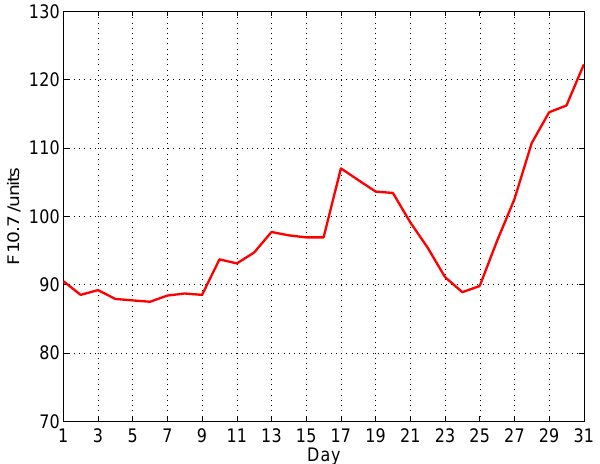
Fig. 5. The F10.7 (solar radio flux) index for July 2011. I-Cheon and Okinawa. The ionosonde data are obtained from the National Geophysical Data Center. Table 1 shows the list of all used ionosonde stations with geographical locations.